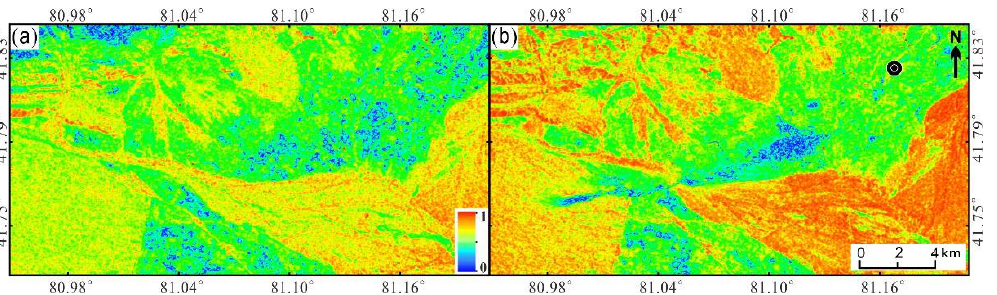
Table 2. Accuracy verification of coherent change detection.